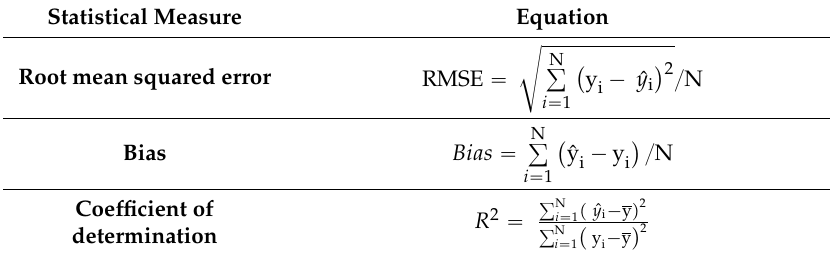
Table B1. Statistical metrics that were used in the evaluation of satellite-derived start of season in deciduous broad-leaf forest (DBF_SOS sat ) and JSBACH simulations of the start of season in deciduous forest (DBF_SOS mod ) and evergreen forest (ENF_ SOSmod,loc ; ENF_SOS mod ). Statistical Measure Equation Root mean squared error RMSE “